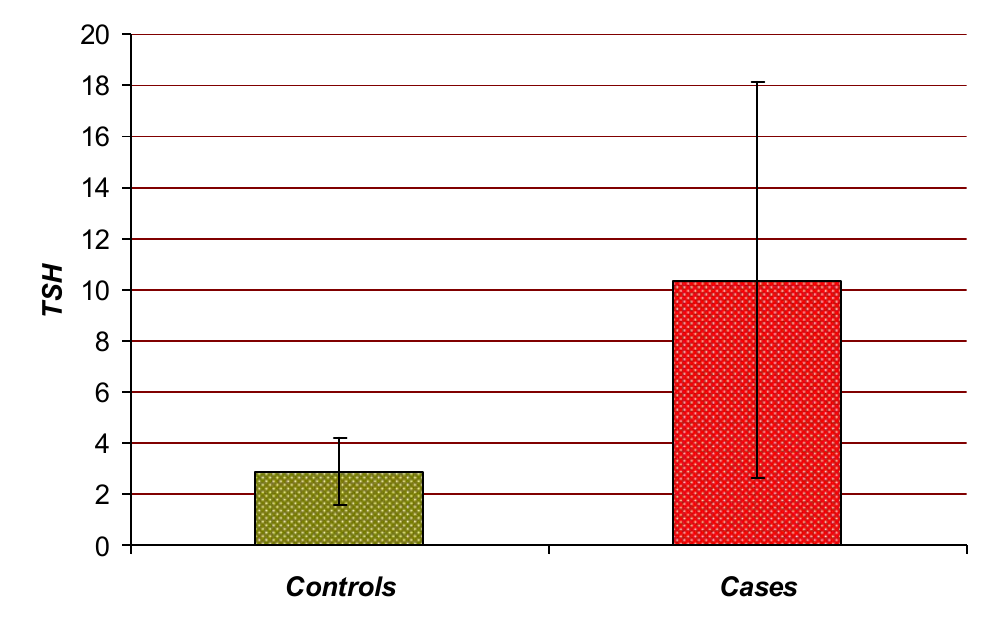
Figure 4C: Comparison of levels of TSH between Controls and